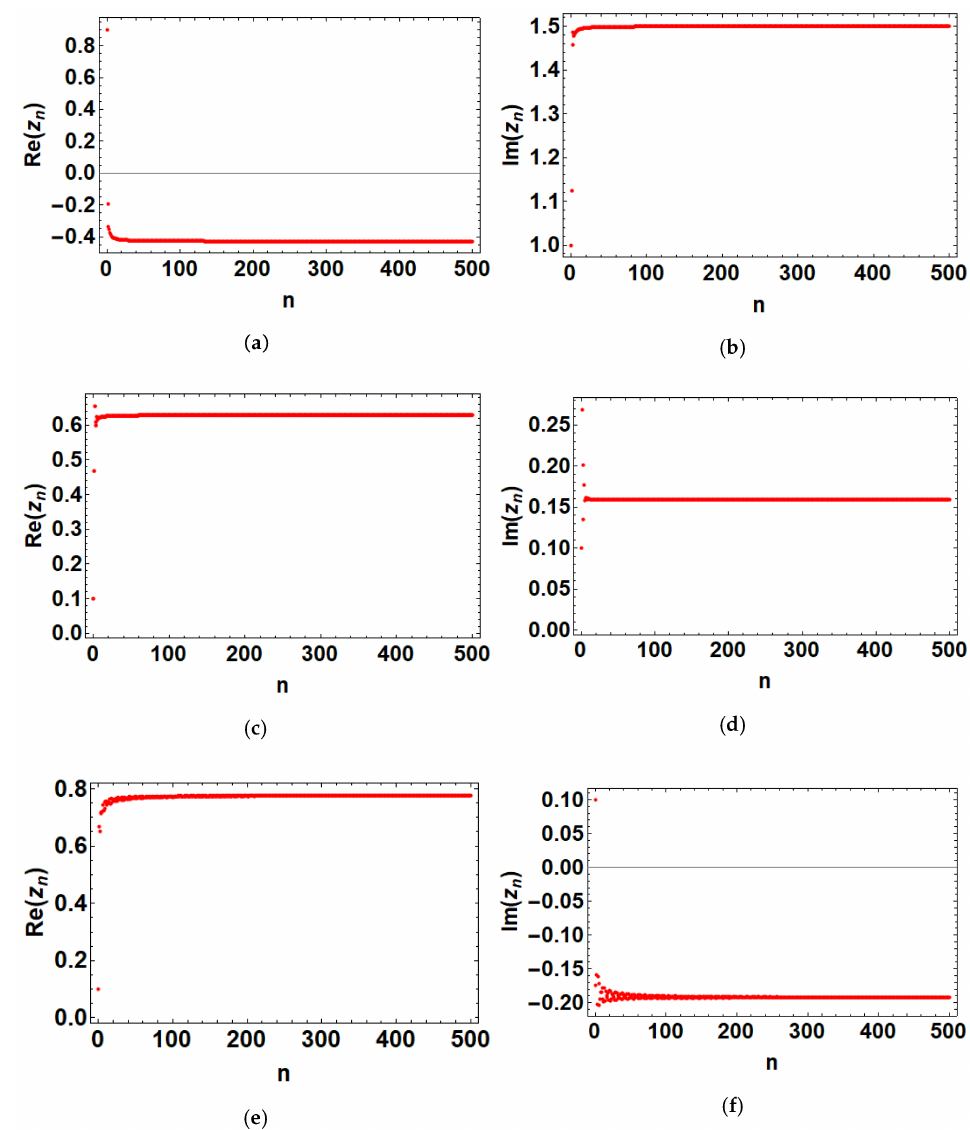
Figure 1. The time series solutions of the generalized fractional complex cosine map at ( a , b ) p = 1, α = 0.95, q = 2 − 1.5 i , ( c , d ) p = 2, α = 0.85, q = 1.2 − 0.2 i , and ( e , f ) p = 2, α = 0.7, q = 1 + 0.3 i